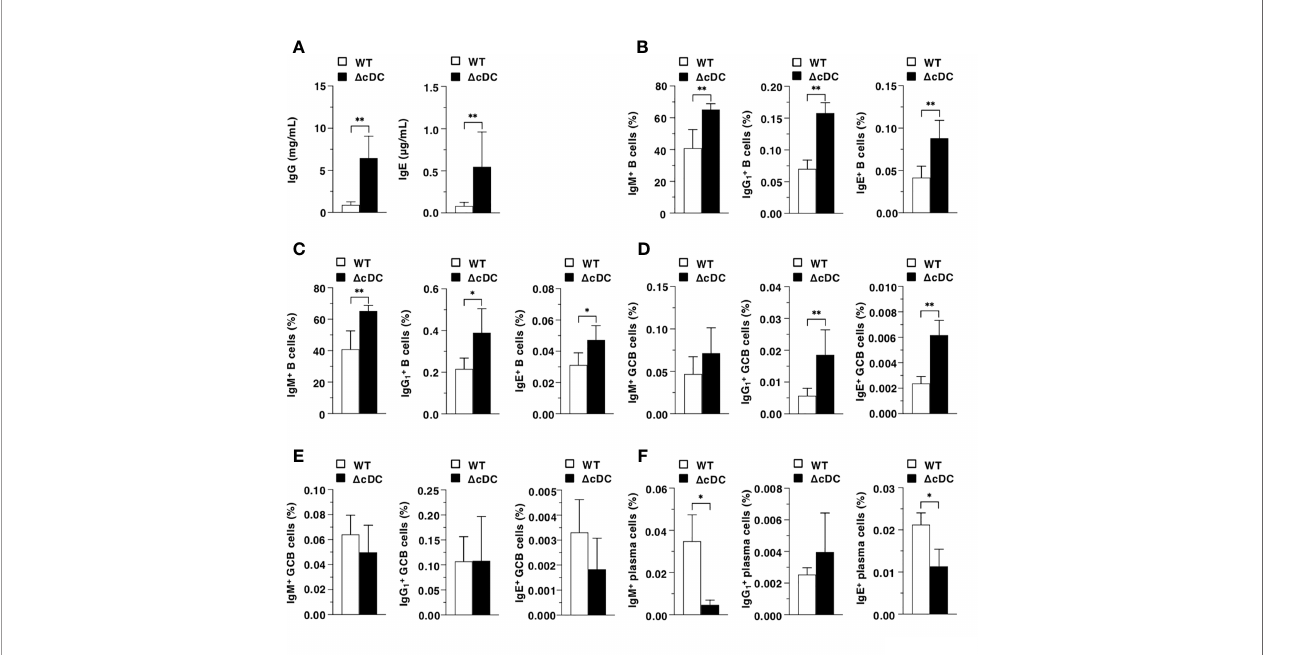
FIGURE 5 | Constitutive loss of cDCs affects the AD-associated B-cell responses in during onset of AD-like in fl ammation. (A) Serum production of IgG and IgE in WT mice and D CD11c hi cDC mice (n = 8 per group) at 16 days after topical application with MC903. (B – E) The frequency of the subsets of IgM + B cells, IgG + 1 B cells, and IgE + B cells in whole (B, C) and GC (D, E) of Spl (B, D) and EDLNs (C, E) obtained from WT mice and D CD11c hi cDC mice (n = 8 per group) at 16 days after topical application with MC903. (F) The frequency of the subsets of IgM + plasma cells, IgG + 1 plasma cells, and IgE + plasma cells of BM obtained from WT mice and D CD11c hi cDC mice (n = 8 per group) at 16 days after topical application with MC903. Data are obtained from eight individual samples in a single experiment. * P < .05, ** P < .01 compared with WT mice by two-sided paired student t -test. All data are representative of at least 3 independent